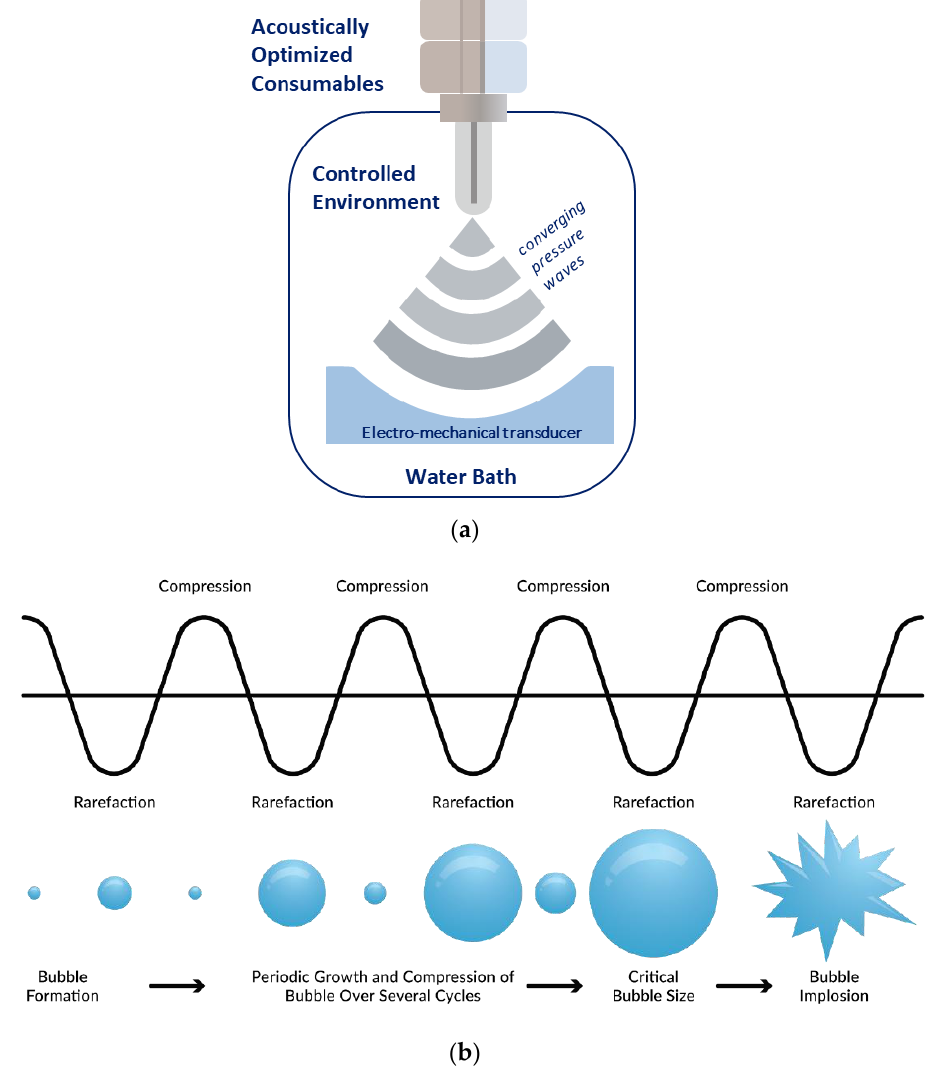
Figure 2. Adaptive Focused Acoustics Fundamentals. Transfer of acoustic energy from a focused- ultrasonicator transducer through a water bath and into a sample ( a ). Generation, oscillation, and collapse of microscopic bubbles in aqueous samples ( b ).